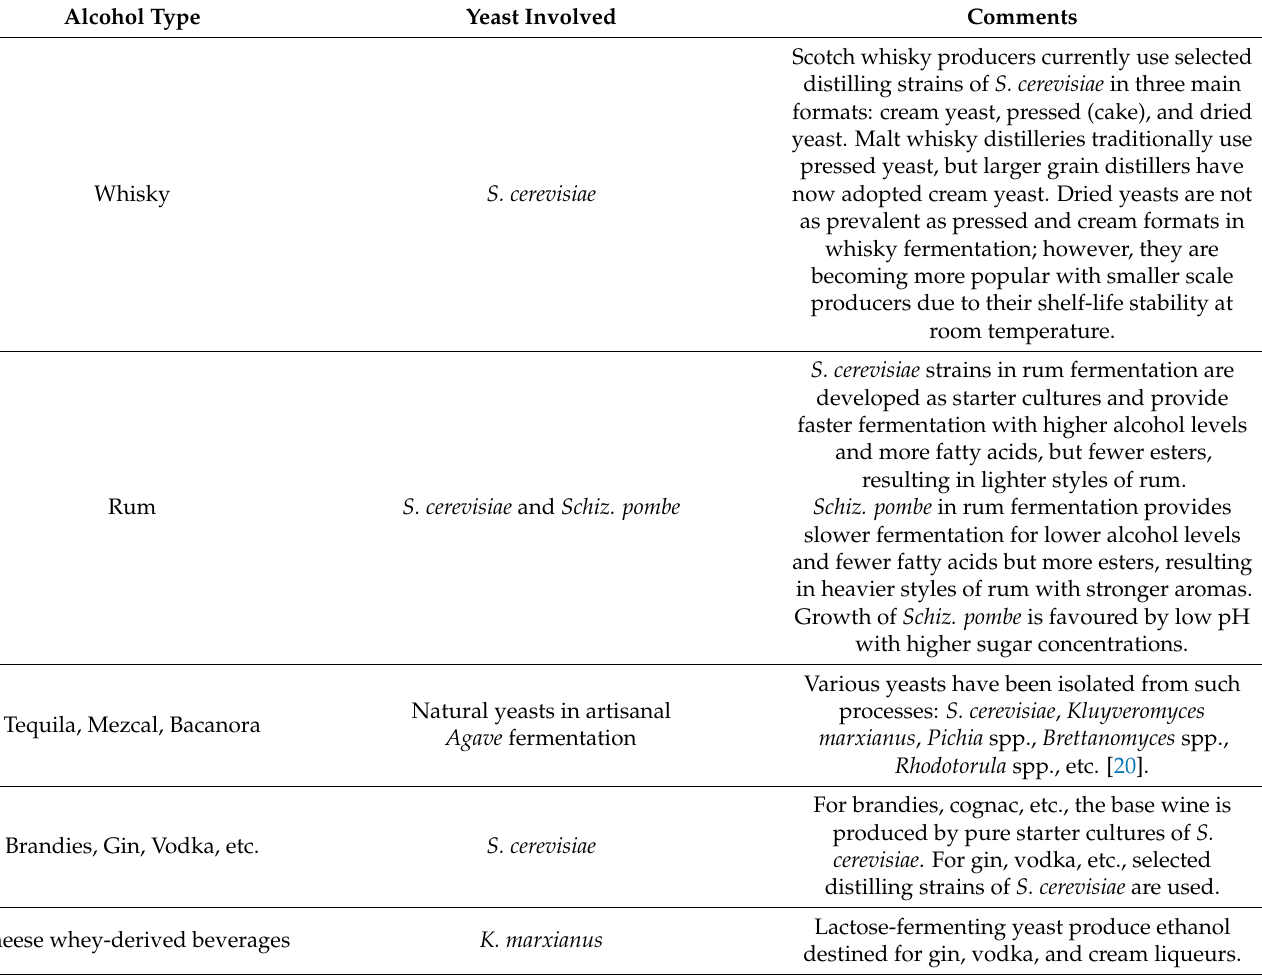
Table 4. Yeasts employed for production of distilled spirits. (Adapted from